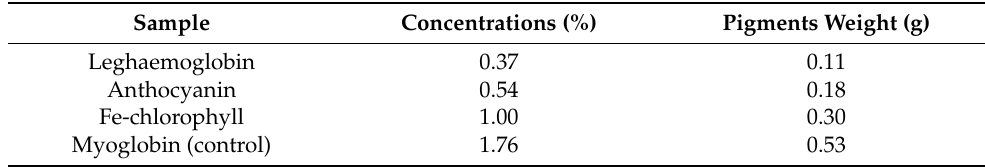
Table 3. Pigment samples weight and concentration.